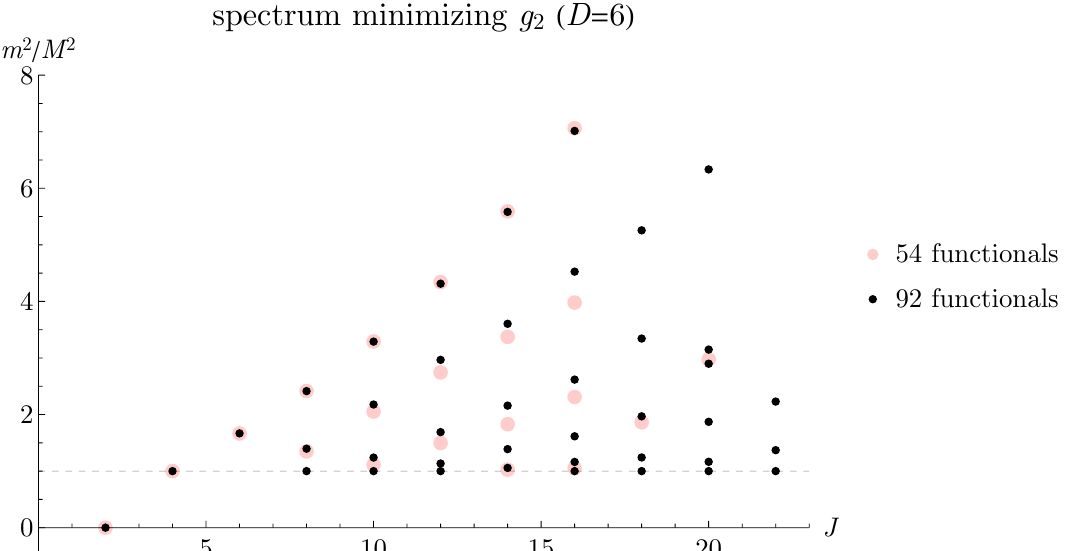
Figure 6 . Extremal spectrum for the problem of minimizing g 2 in spacetime dimension D = 6 . The black points are zeros of the extremal functional, computed using a 92-dimensional space of functionals described in table 2. (We only show zeros that are stable under changing the space of functionals and other parameters.) For comparison, we show the spectrum computed using a 54-dimensional space of functionals in red. The upper trajectory has mostly converged, but the lower trajectories are still changing as we increase the space of functionals. The extremal value of g 2 corresponding to this spectrum is g 2 M 2 / (8 πG ) = − 9 . 57 . In string theory, the spectrum would occupy the upper triangle, but here it is in the lower